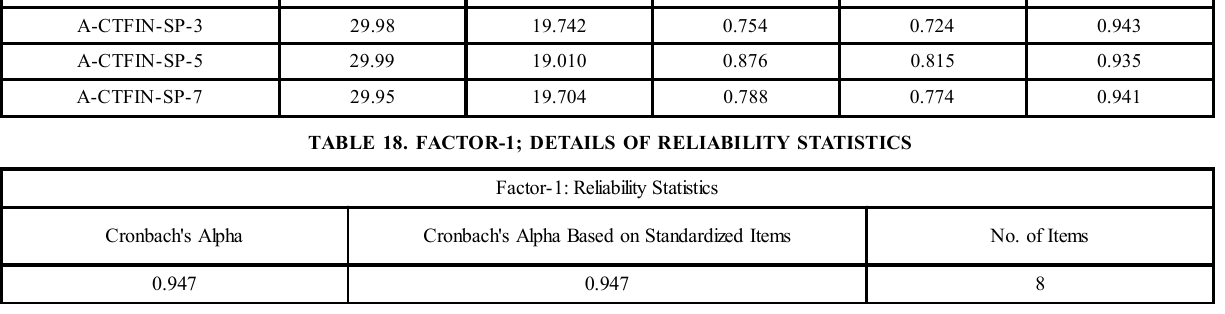
TABLE 19. FACTOR-2; DETAILS OF INTER-ITEM CORRELATION